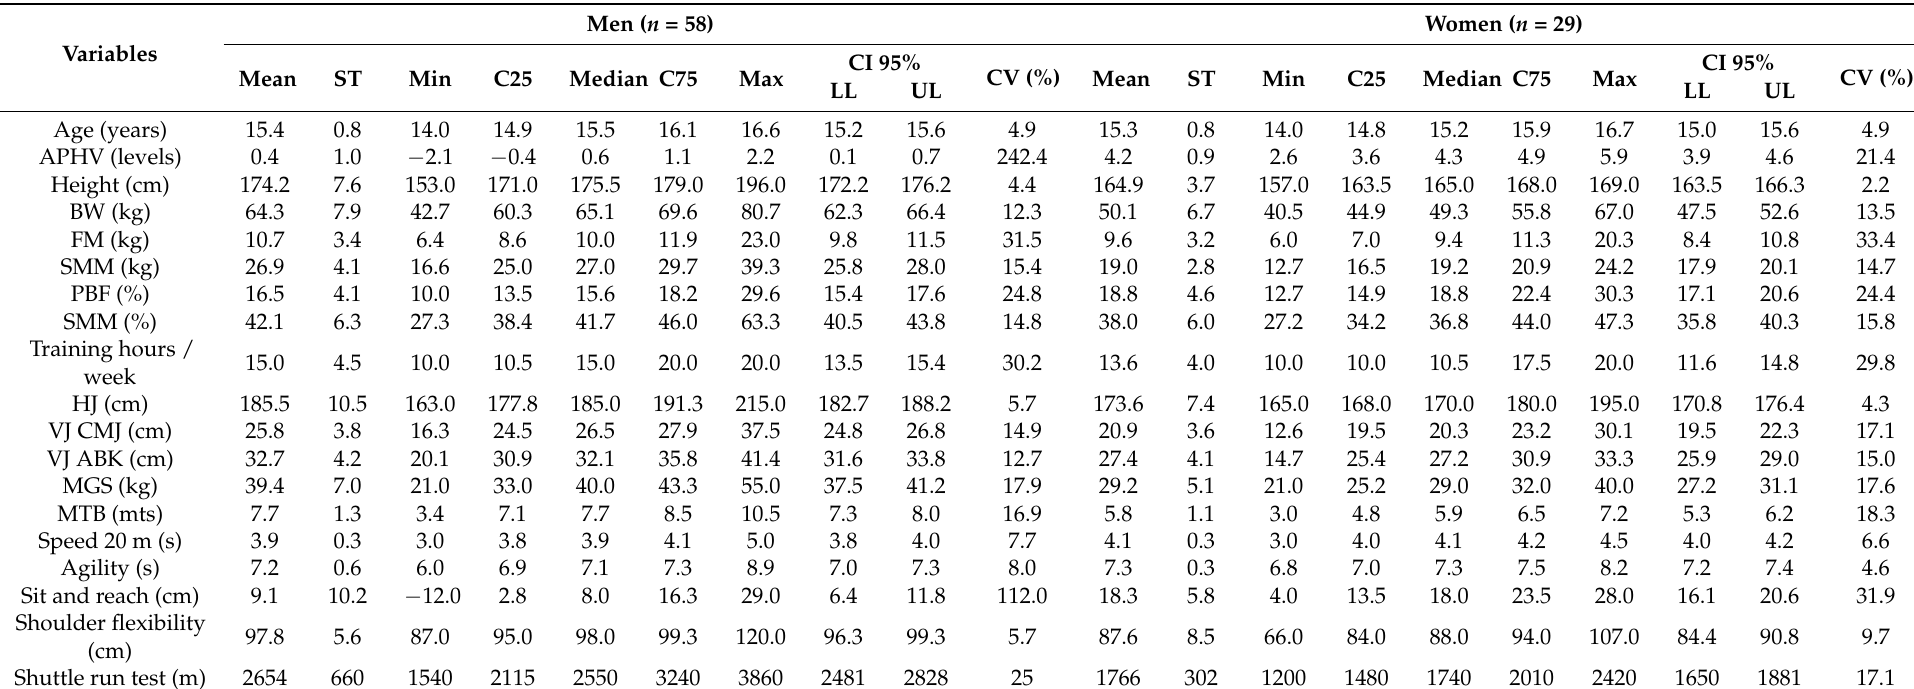
Table 1. Descriptive Characterization of the